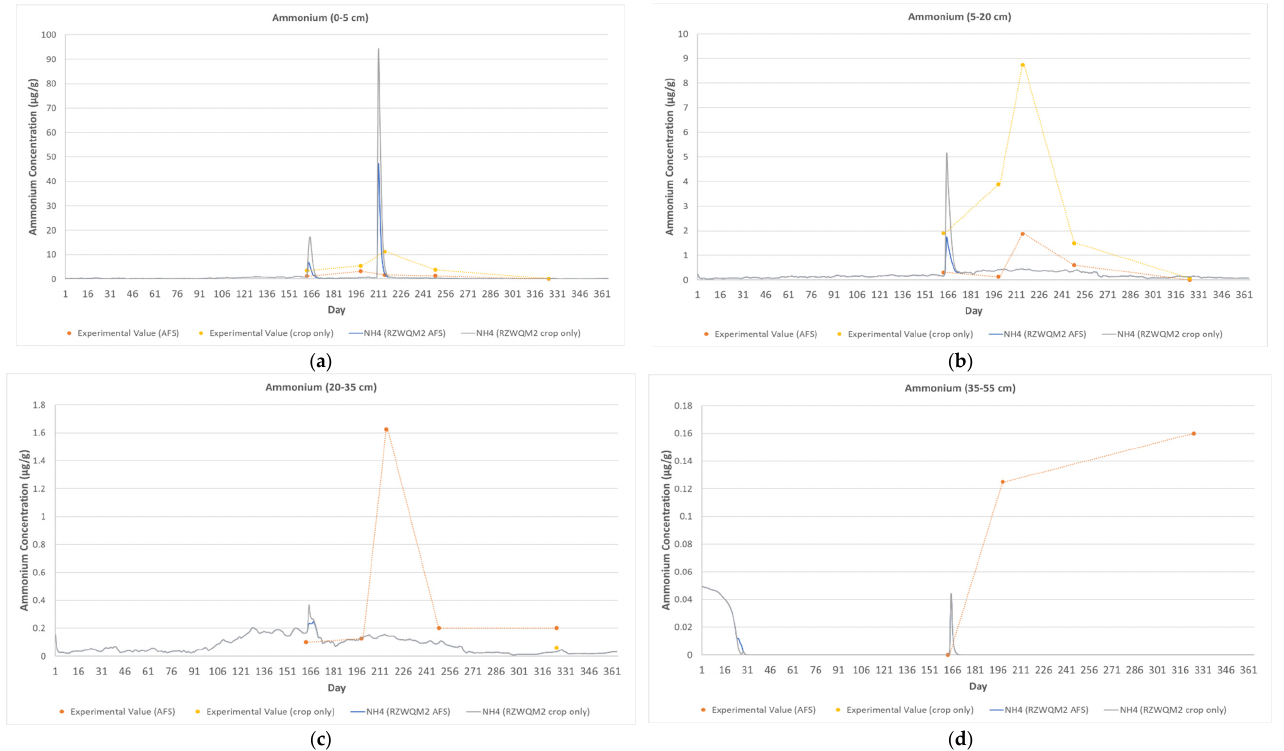
Figure 3. Comparison of ammonium concentrations in the soil profile of the AFS and maize-only system for various sampling depths: ( a ) 0–5 cm, ( b ) 5–20 cm, ( c ) 20–35 cm, and ( d ) 35–55 cm (where no points are presented, sampling was not possible due to soil compaction. Fertilization was carried out on days 163 and 210).